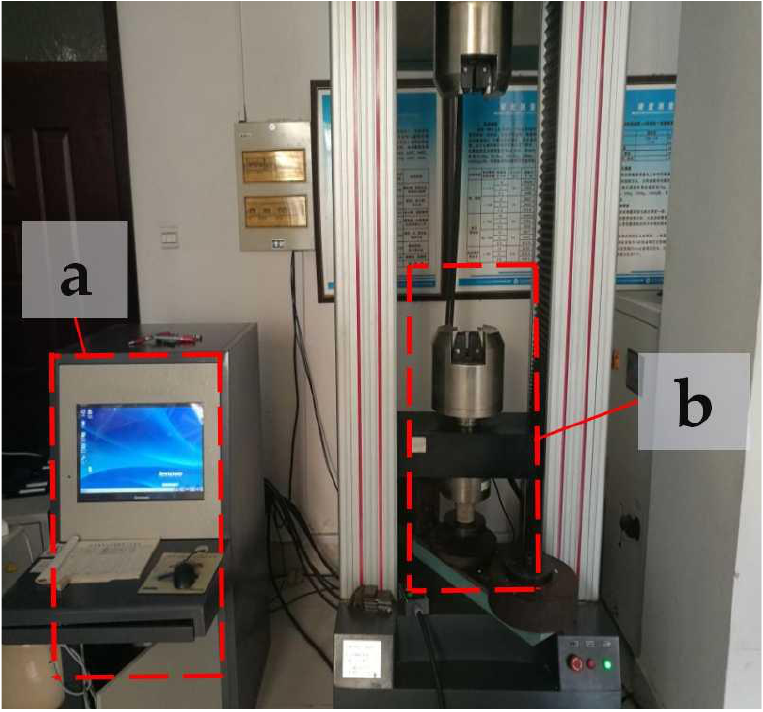
Figure 3. Microcomputer-controlled electronic universal testing machine: ( a ) electronic universal testing machine console; ( b ) electronic universal experiment machine test bench.